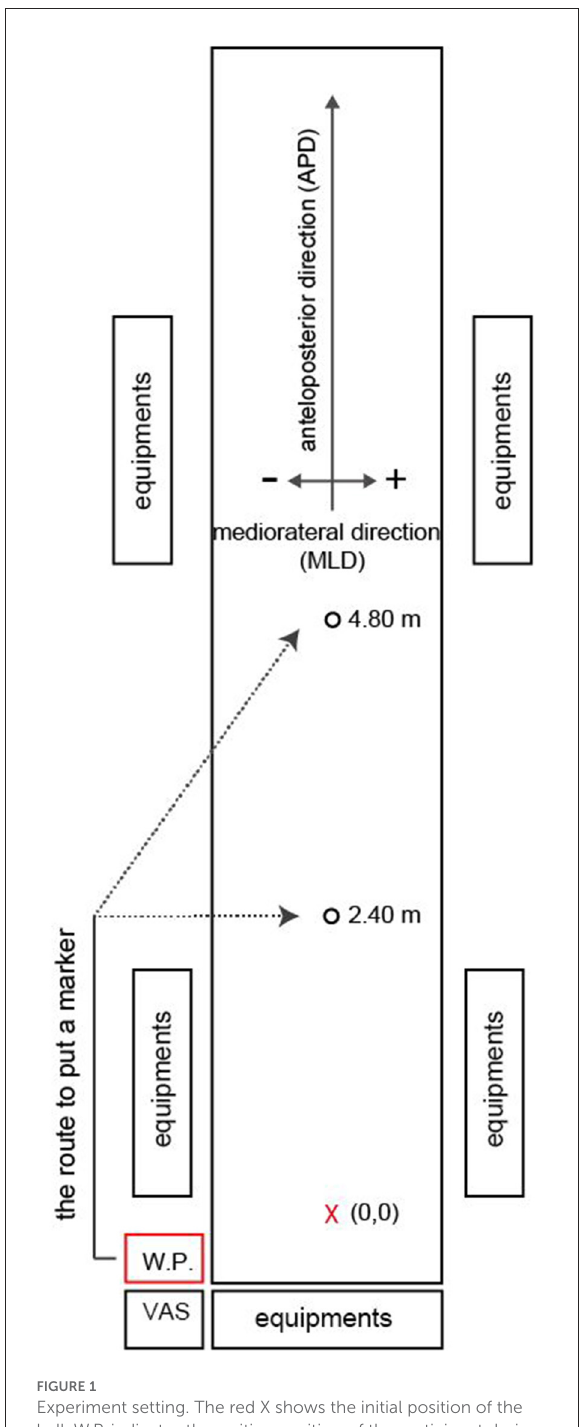
FIGURE1 Experiment setting. The red X shows the initial position of the ball. W.P. indicates the waiting position of the participant during the trials. After hitting, participants turn to the desk and mark their rating on the visual analog scale (VAS). The reason participants walk the specified route is to avoid specifying the physical distance to the target. The targets are projected from the ceiling by two